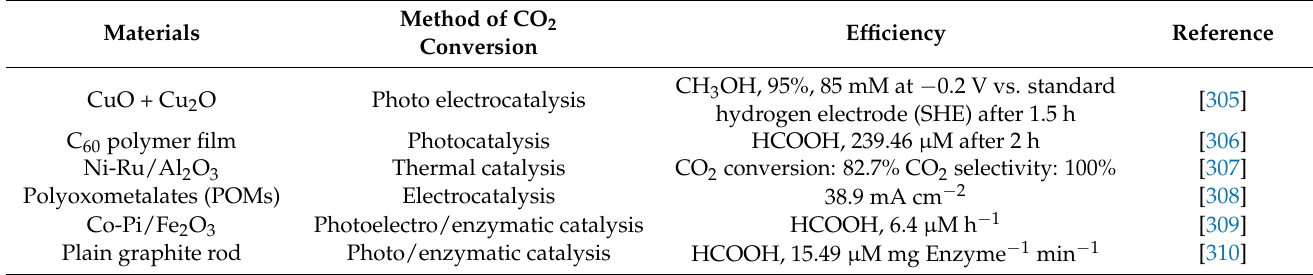
Figure 7. A schematic of the CO 2 chemical conversion methods [304]. Table 9. Performance evaluation of various CO 2 reduction